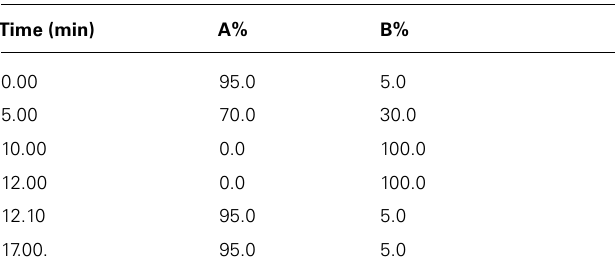
Table 1 | Gradient of LC Method for